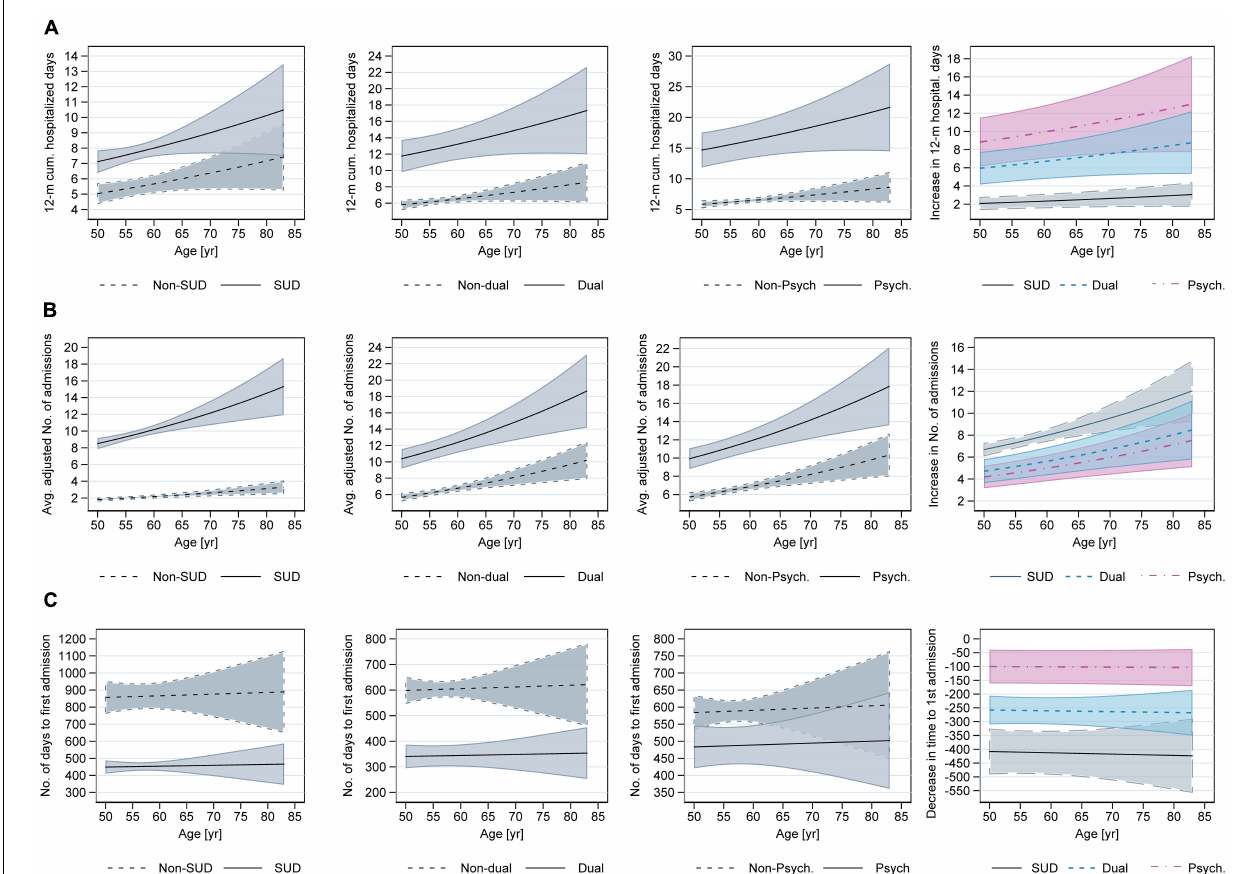
FIGURE 1 | Adjusted predictions and partial effects for SUD, dual and psychiatric diagnoses across age given for 3 different outcomes: 12-month cumulative hospitalized days (A) ; Hospital admission rate (B) ; Time to first hospital admission (C) . The last columns in the figure show partial effects of the independent variables across age. For example, the partial effect for SUD is calculated as the change from no SUD diagnoses to SUD diagnoses. The shaded area in the graphs show 95% confidence